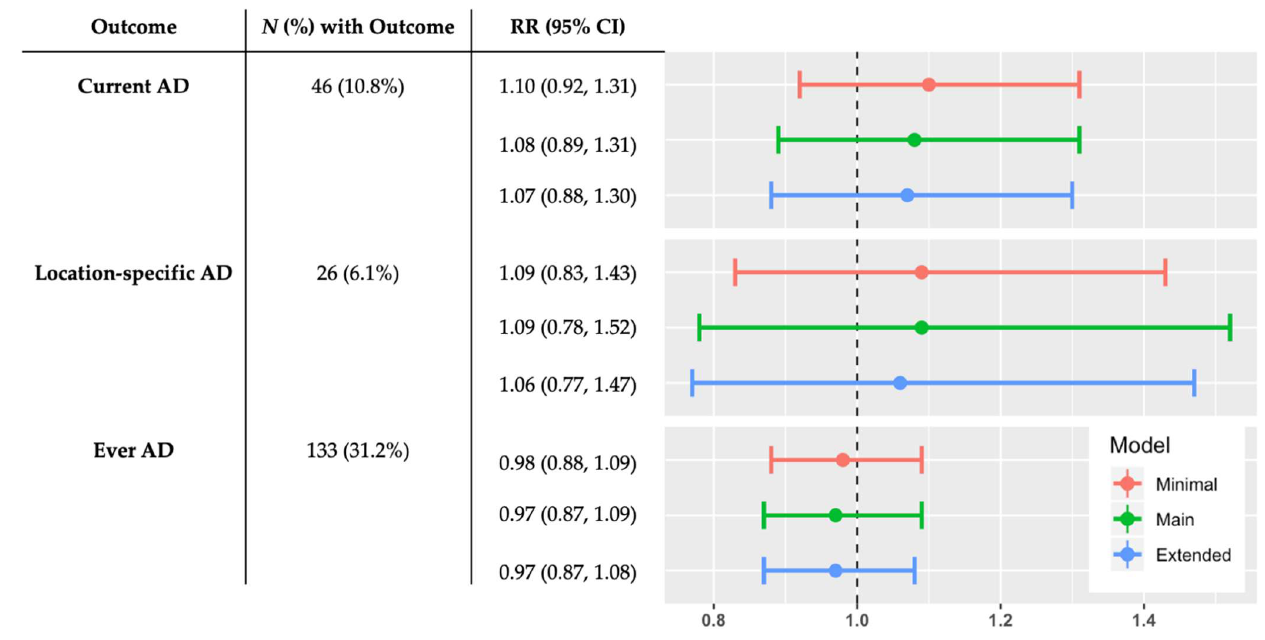
Figure 1. Sample frequencies of outcomes and adjusted associations between prenatal stressful life events and atopic dermatitis outcomes. Minimal model adjusts for child sex, child age, maternal education, household income, maternal race, maternal ethnicity, and maternal history of atopy. Main model adjusts for minimal model covariates and maternal age at delivery, maternal current stress, recruitment site, other children in home, and prenatal farm animal exposure. Extended model adjusts for main model covariates and paternal history of atopy, prenatal smoking, prenatal cat or dog ownership, delivery type, breastfeeding duration, and prenatal antibiotics. Abbreviations: AD, atopic dermatitis; CI, confidence interval; RR, risk ratio. Table 3. Adjusted associations between prenatal stressful life events and child atopic dermati- tis outcomes across strata of child sex, maternal history of atopy, and prenatal maternal resilient coping